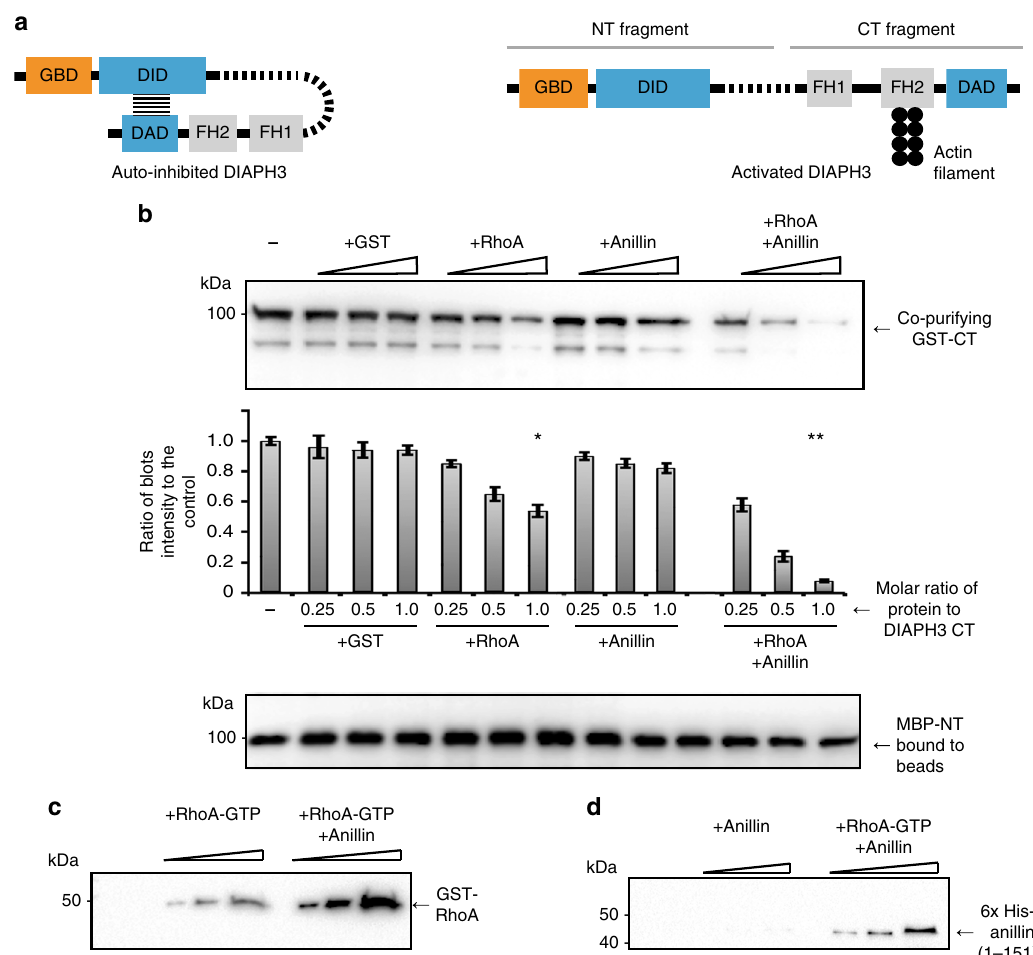
Fig. 1 Anillin enhances RhoA-mediated release of DIAPH3 intramolecular auto-inhibition interaction. a Schematic of DIAPH3 domain organization in the auto-inhibited and activated states (not to scale). b Immunoblots and quanti fi cation to determine the amount of GST-DIAPH3-CT and MBP-DIAPH3-NT bound to amylose beads in the presence of increasing concentrations of GST, GST-RhoA, and 6× His-anillin (1 – 151 aa). Values normalized to the amount of MBP-DIAPH3-NT immobilized on beads. Each binding assay was repeated at least three times. Error bars indicate ± s.e.m. * p = 0.014, ** p = 0.0009 compared to GST control, Student ’ s t test. n = 3. c MBP-DIAPH3-NT and GST-DIAPH3-CT were pre-mixed, then incubated with either GST-RhoA, 6× His- anillin 1 – 151 , or both. MBP-DIAPH3-NT was re-isolated on amylose beads and immunoblots performed to detect co-purifying RhoA and d